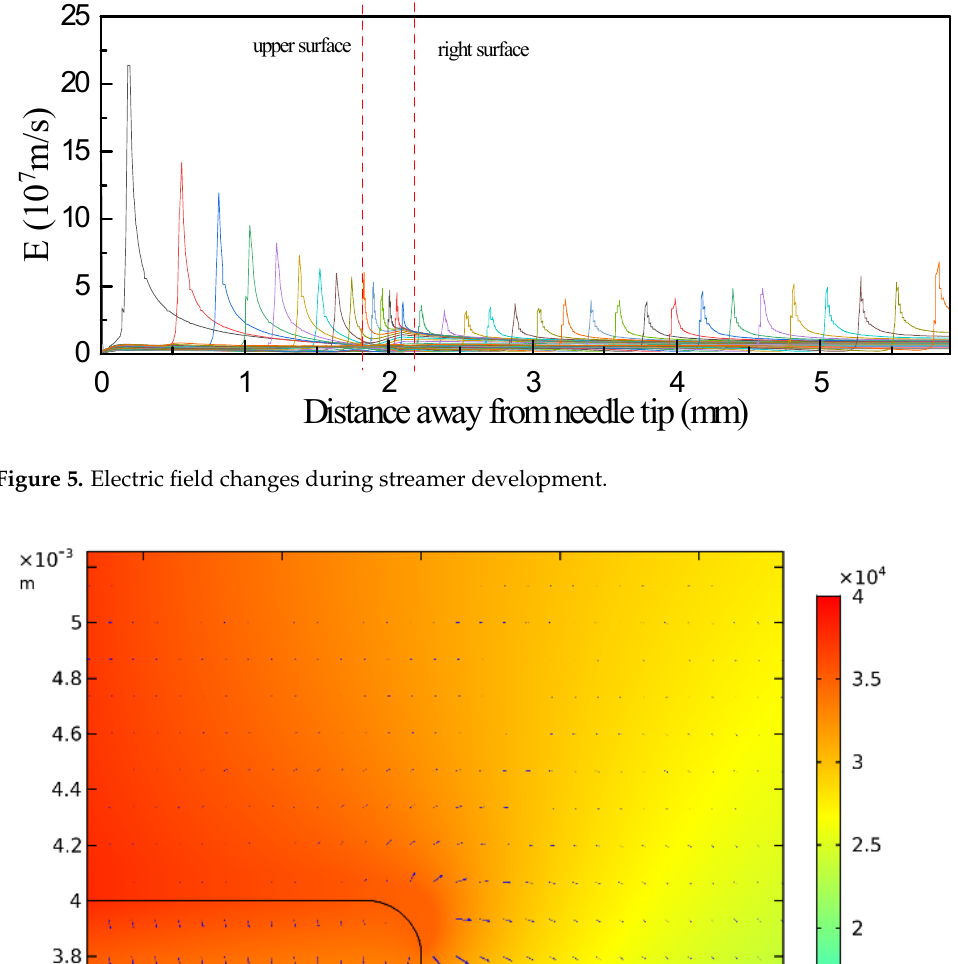
Figure 4. The distribution of the electric field (V/m), from 0.02 ns ( a ) to 2.47 ns ( i ); the scale unit is millimeters (mm). ( a – c ) development of streamer on upper surface of insulator; ( c , d ) streamer transitions from the top surface of the insulator to the right surface; ( d – i ) development of streamer on the right surface of insulator.